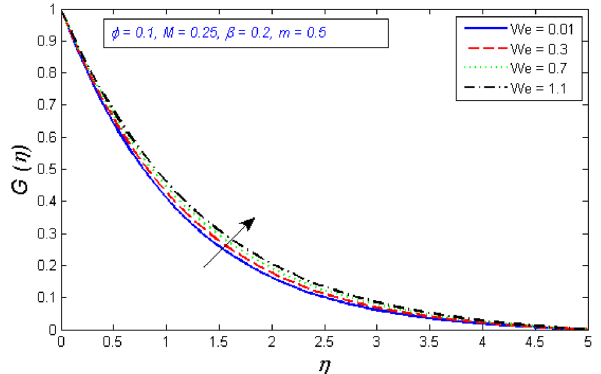
Figure 5. Represents variation of tangential velocity distribution for several number of Ree-Eyring Weissenberg number We .